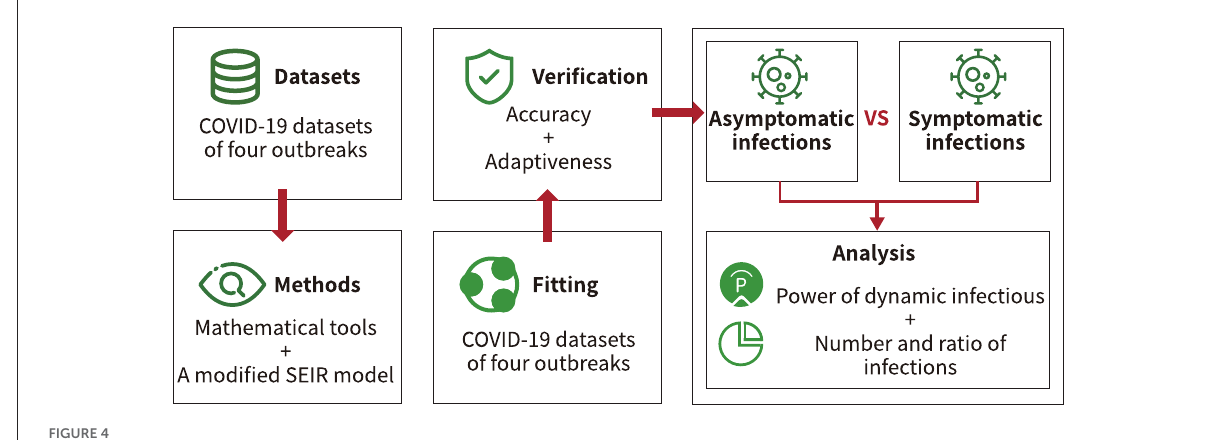
FIGURE4 Experimental